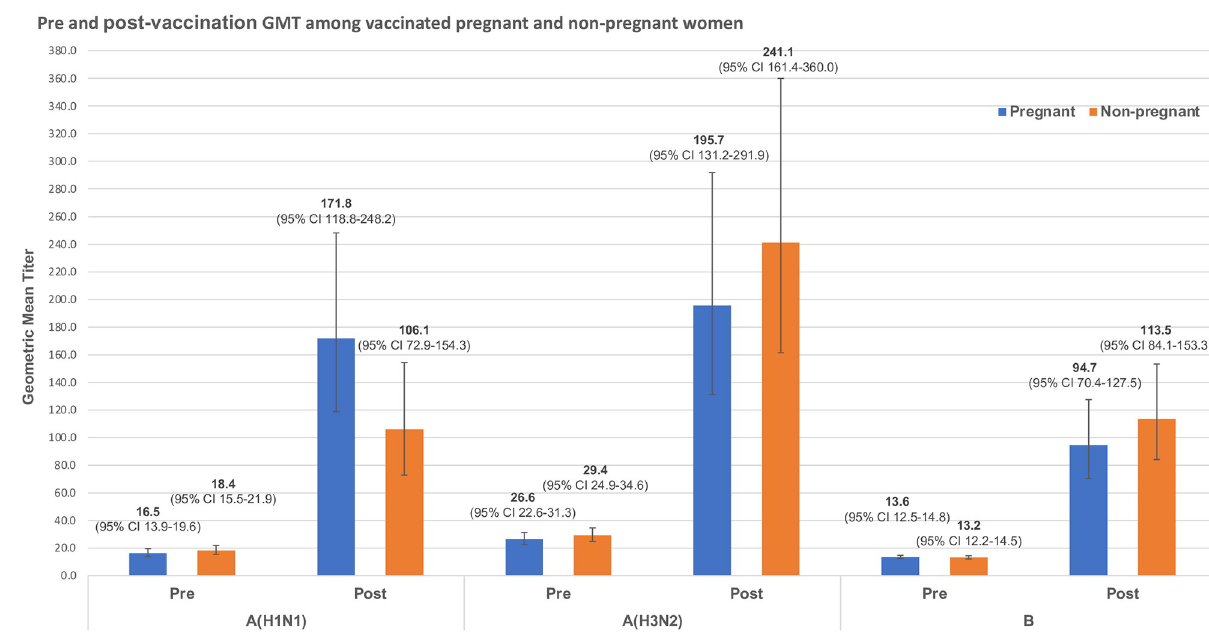
Fig 2. Comparison of influenza antibody geometric mean titers before and after vaccination between pregnant and non-pregnant participants.